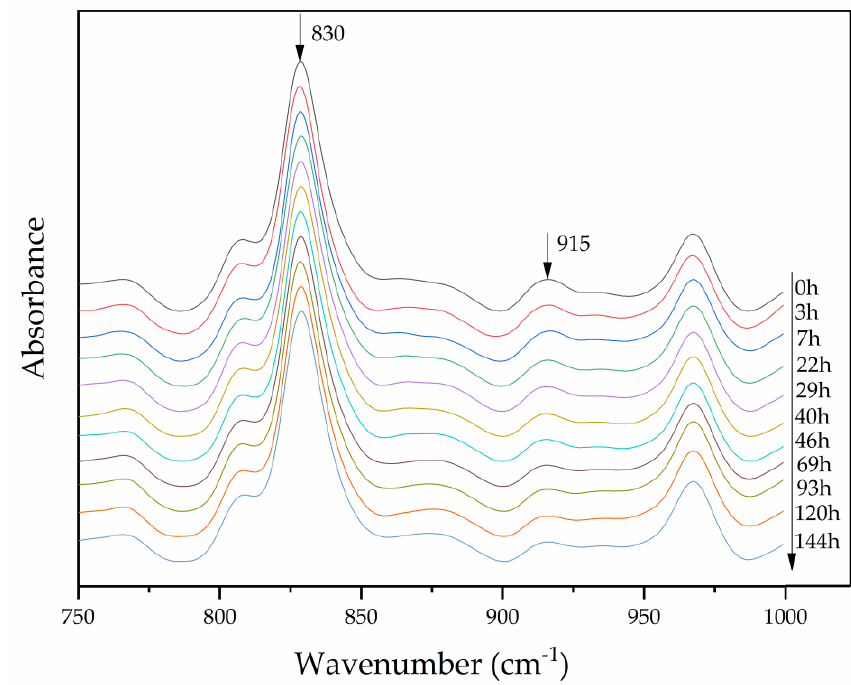
Figure 3. Local FTIR spectra of epoxy asphalt.